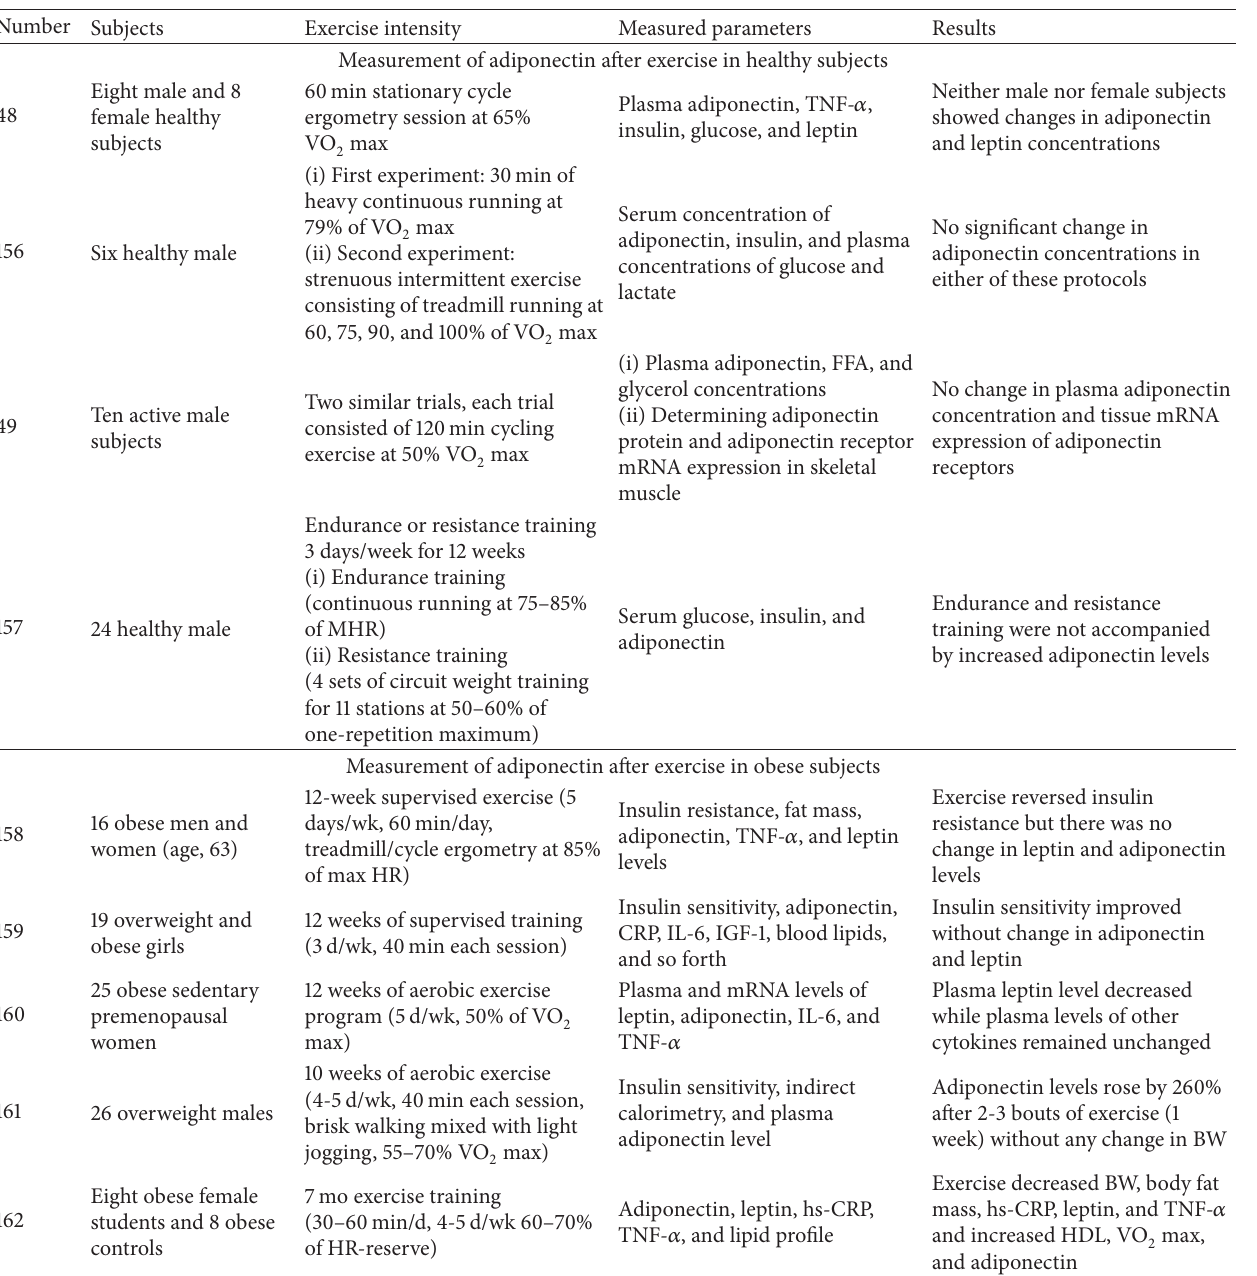
Table 1: Summary of selected clinical trials in which adiponectin levels have been measured as a clinical outcome before and after exercise. Number